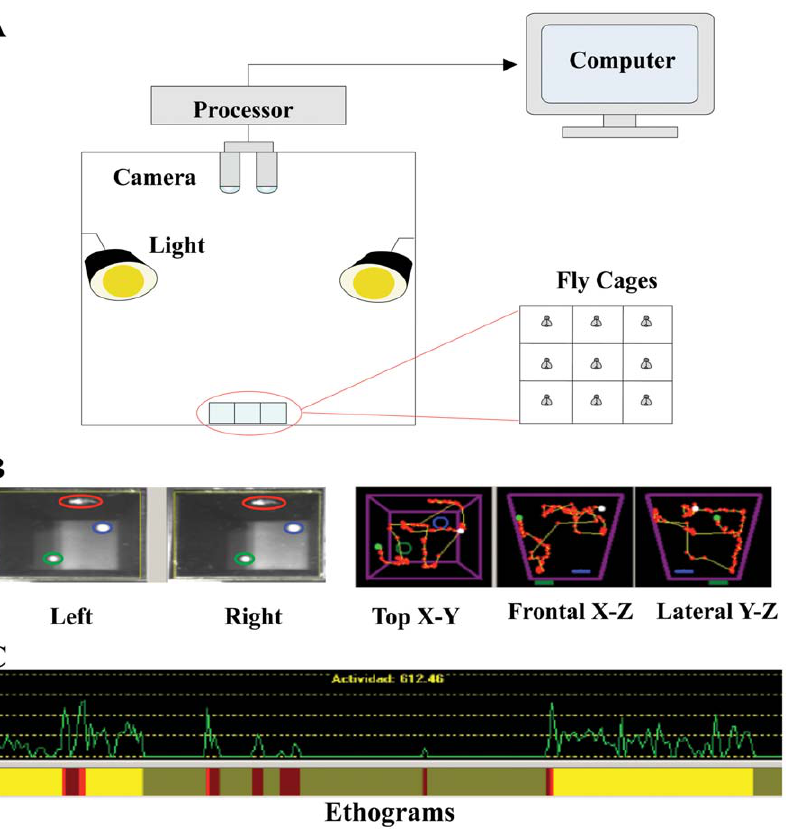
Figure 1. Overview of the behavior monitor system. ( A ) The hardware of the BMS consists of one 9-cage behavior arena, lighting, two cameras and a computer. Each cage has two fixed positions at the bottom to provide water and food (not depicted) to individually housed flies. ( B ) 3-D coordinate trajectories are generated by the software of the BMS from left and right video images taken by the two cameras. ( C ) The BMS software automates classification of six behaviors color coded in the ethogram based on the activity values and relative position of the fly to water and food sources using 3D trajectory data.